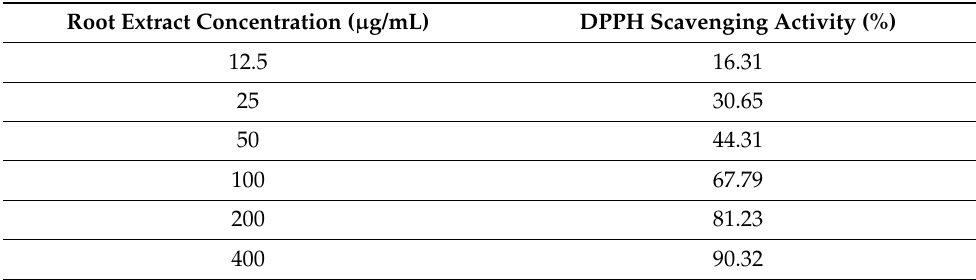
Table 3. Concentration of hydromethanolic root extract of D. stramonium and its DPPH scavenging activity (%)